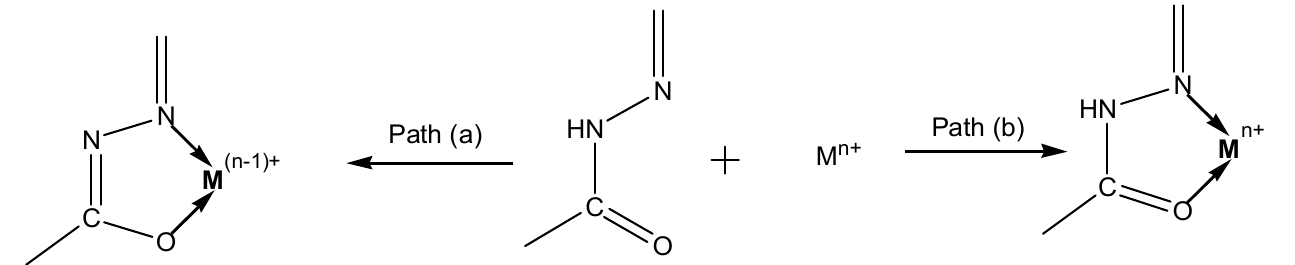
Figure 2. Structure representation of mono-( a ), di-( b ) and tri-( c ) hydrazone ligands.